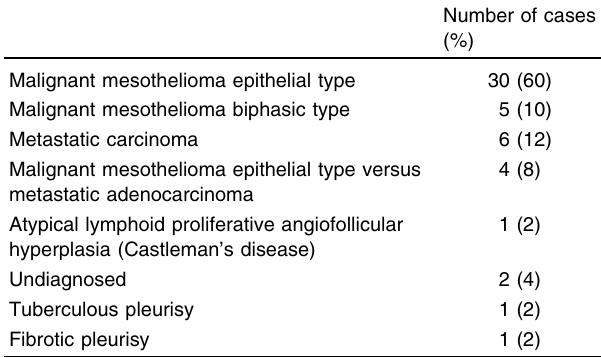
Table 7 Illustration of complicated